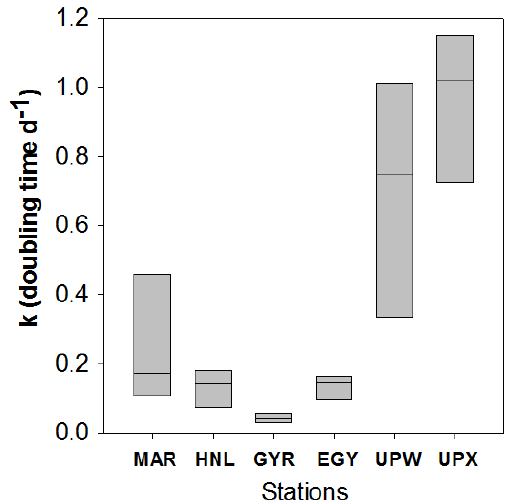
Figure 8. Diatom doubling times k (in d − 1 ) as Tukey box plot of all data available per vertical profile for each station of the BIOSOPE